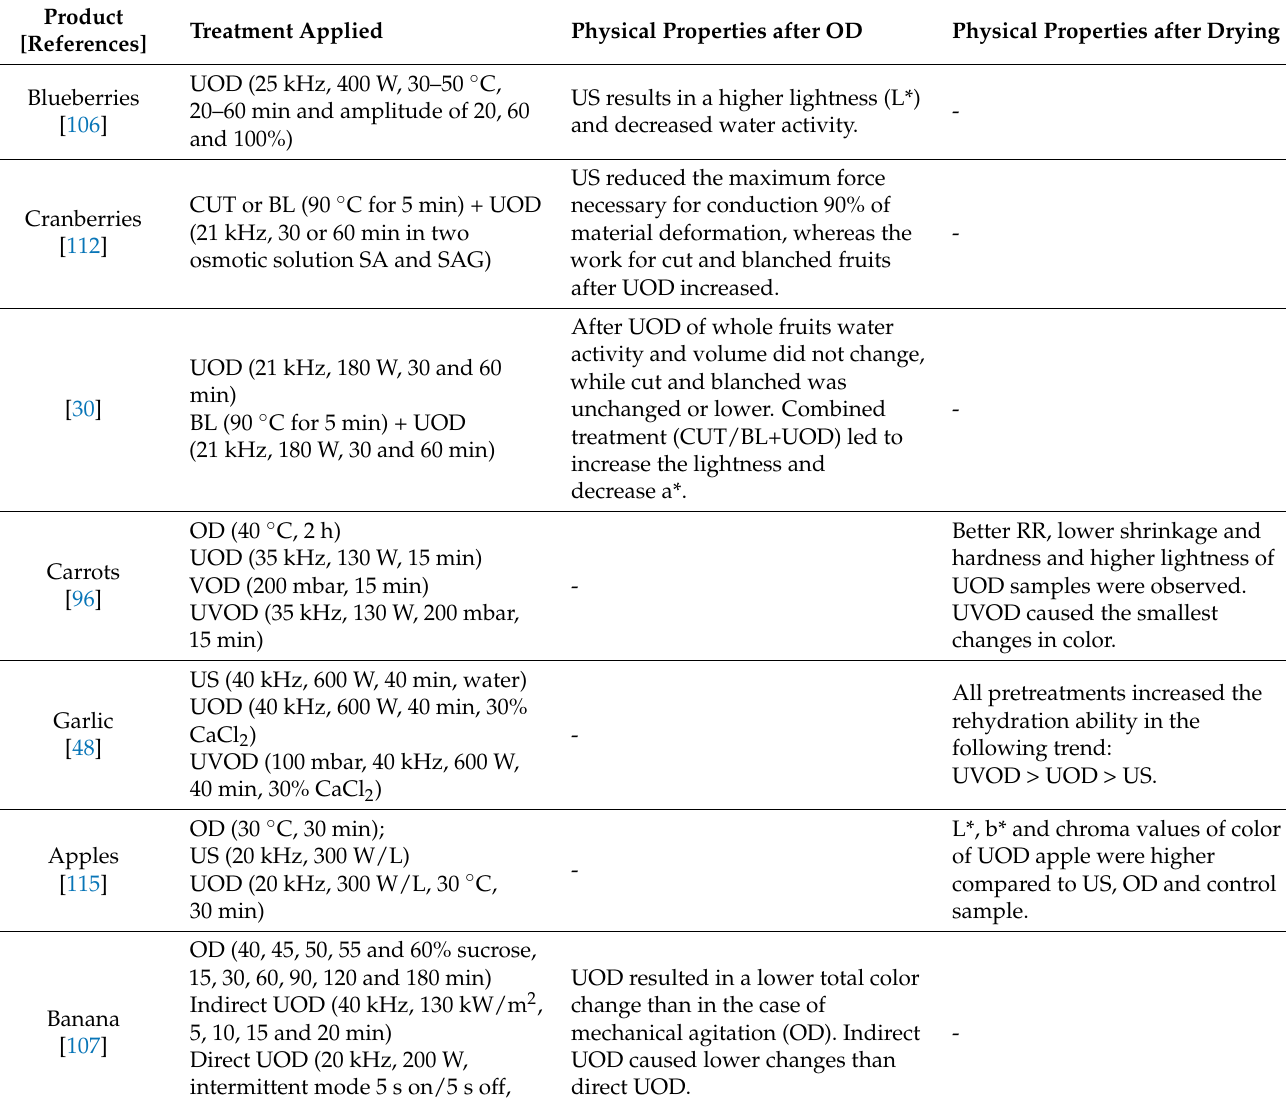
Table 1. The physical properties of products osmo-dehydrated with the assistance of